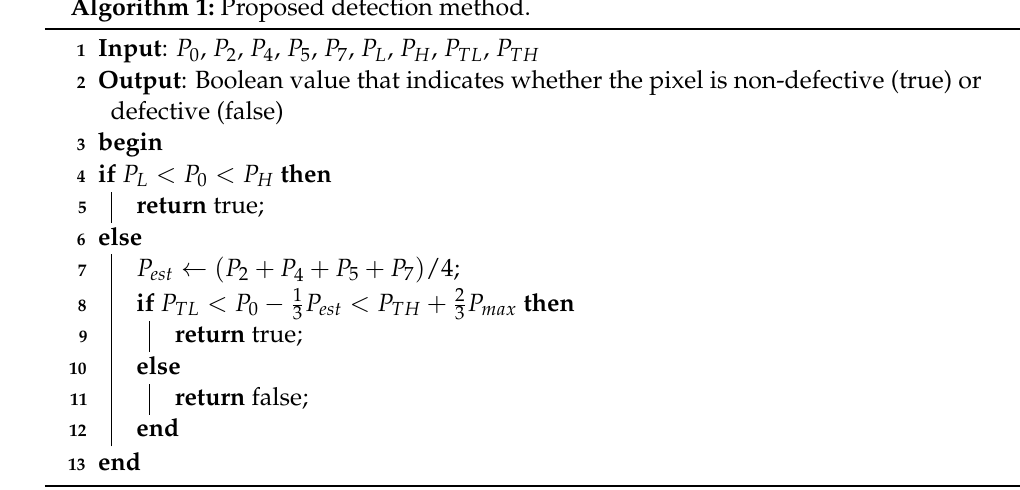
Algorithm 1: Proposed detection